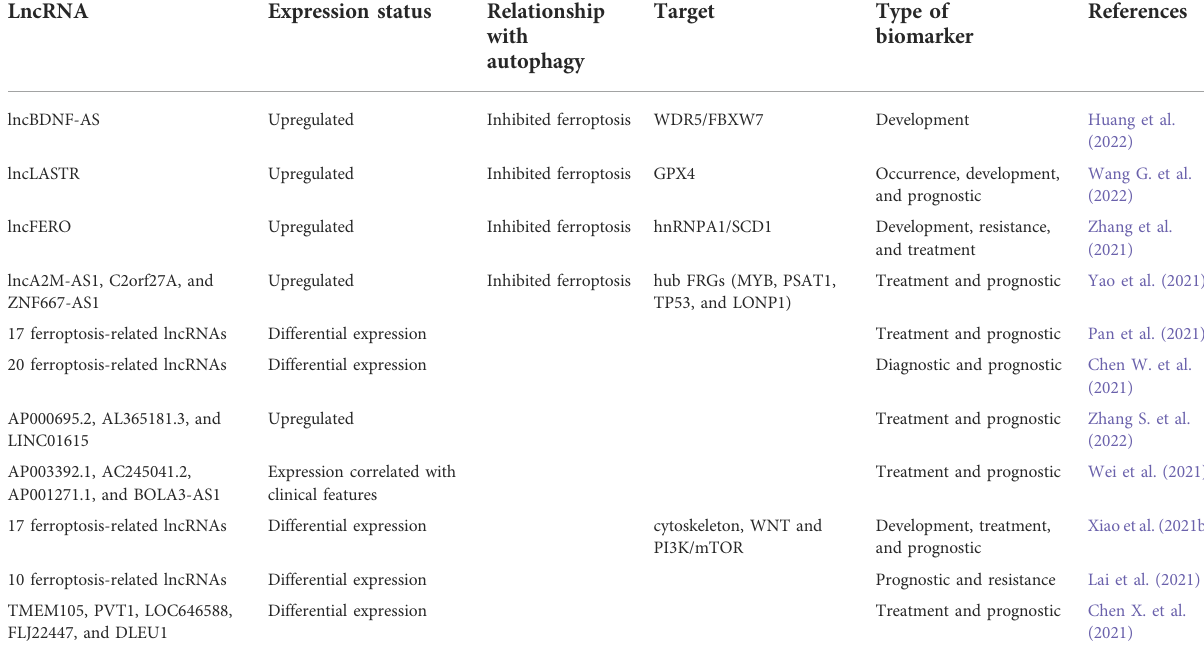
TABLE 2 Overview of the role of ferroptosis-related lncRNAs in